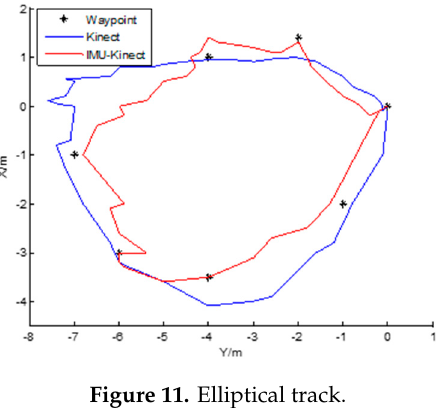
Table 6. Absolute values of the coordinate errors (in meters).